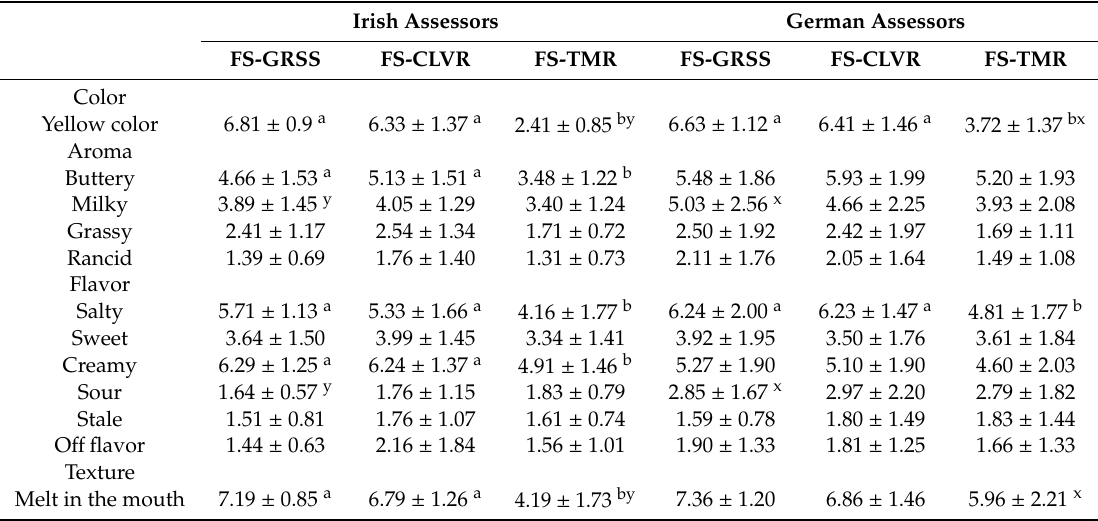
Table 2. Cross-cultural comparison of RDA evaluation by Irish and German assessors of